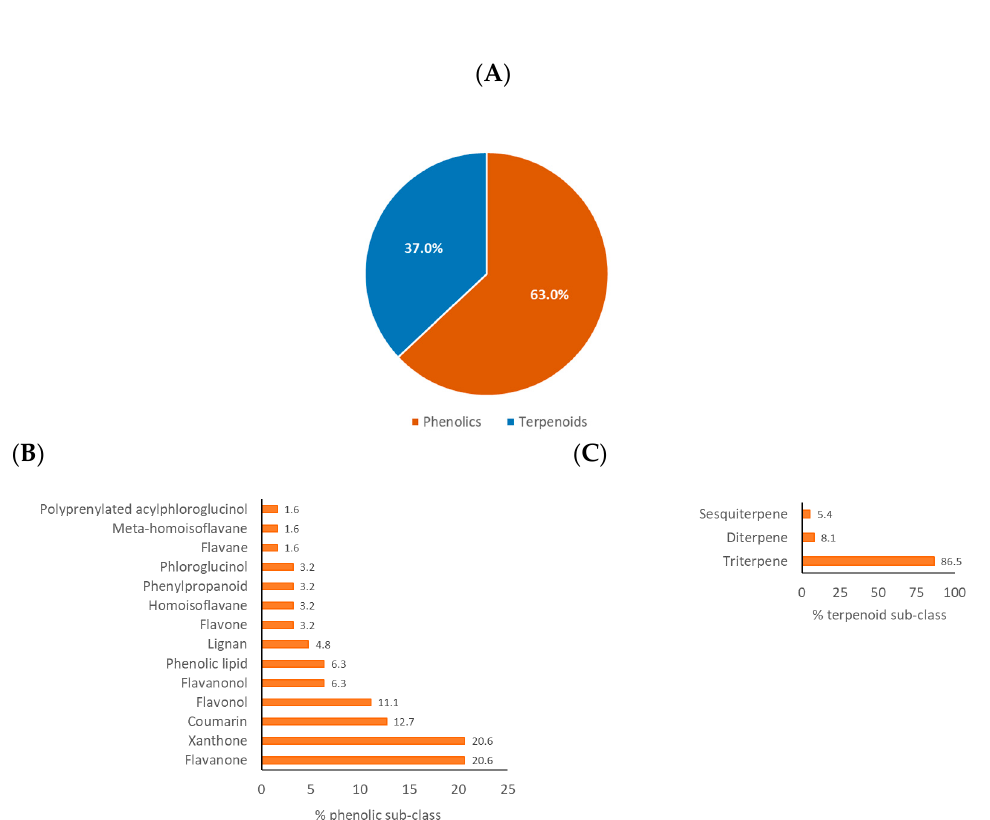
Figure 6. ( A ) Class of compounds isolated from HBP ( n = 502) (phenolics and terpenoids include their glycosides); ( B ) sub-class of phenolics; ( C ) sub-class of terpenoids (overlapped compounds were removed).